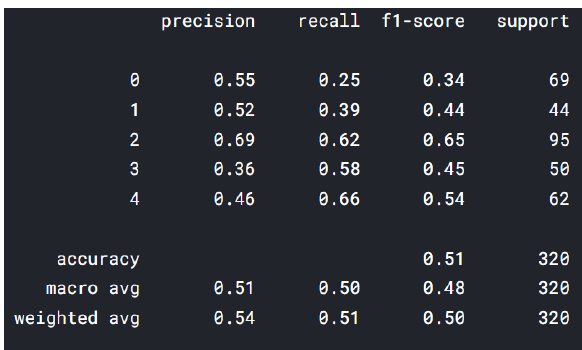
Figure 6. Vgg16 classification report.